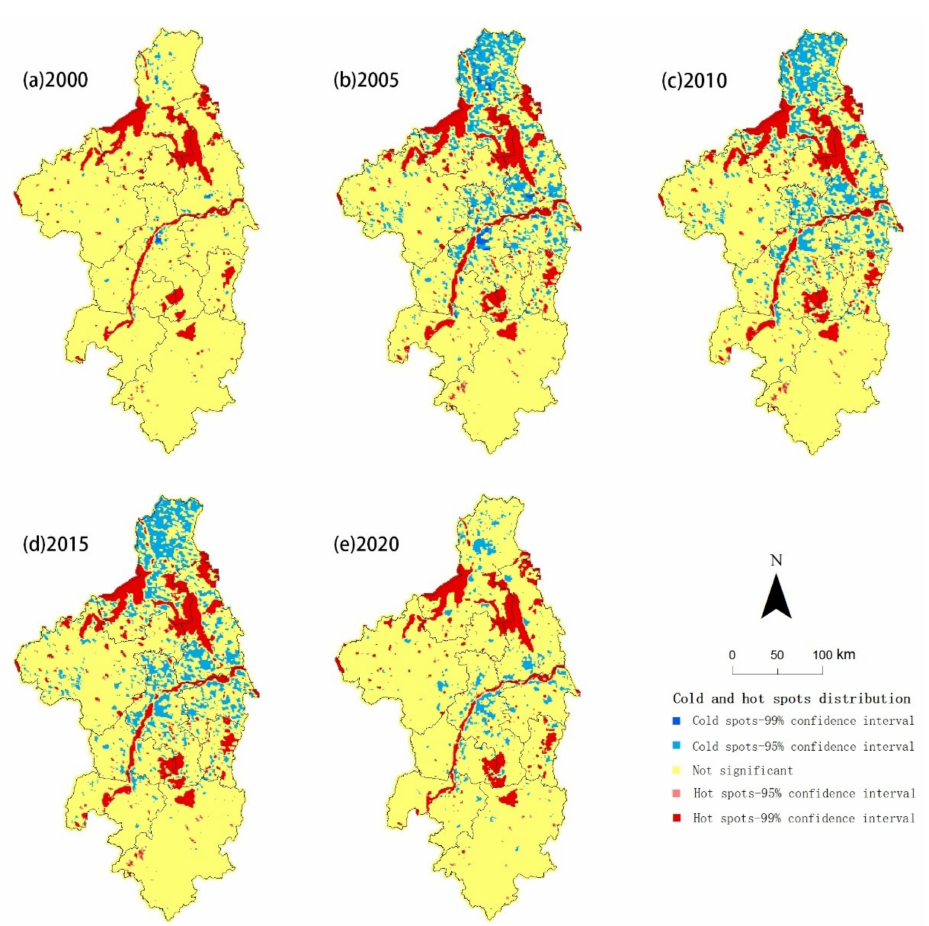
Figure 4. ESV cold spots and hot spots distribution during 2000–2020.